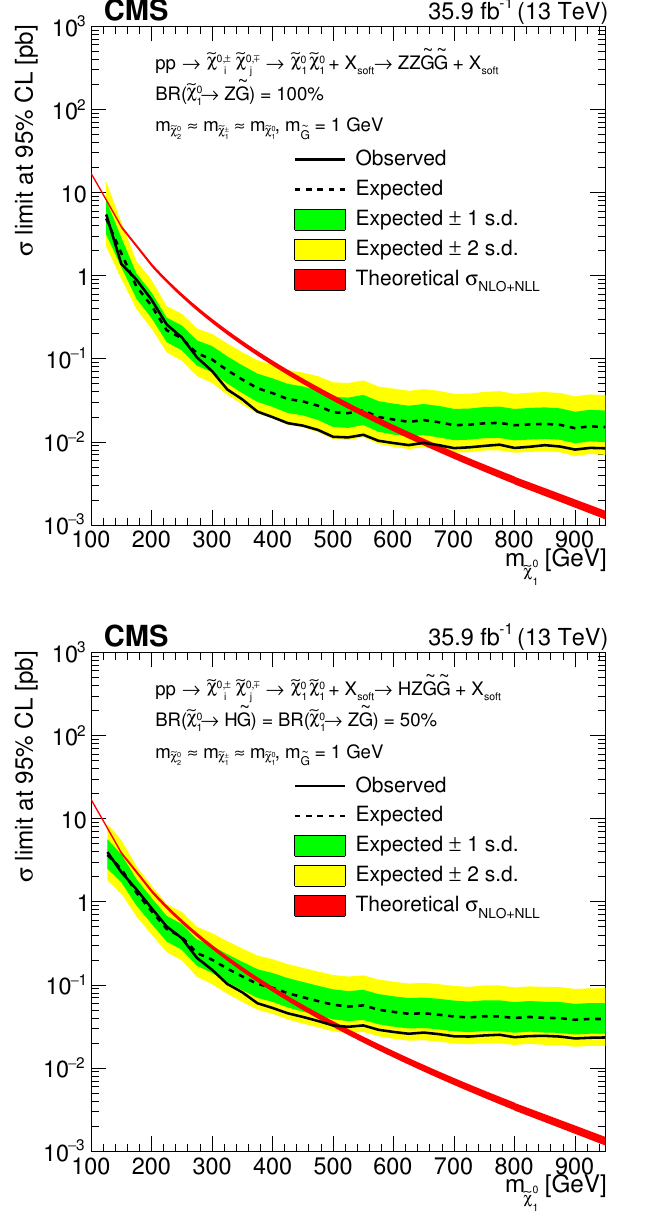
Figure 9 . Cross section upper limit and exclusion lines at 95% CL, as a function of the for the search for EW production in the ZZ topology (upper) and with a 50% branching fraction to each of the Z and Higgs bosons (lower). The red band shows the theoretical cross section, with the thickness of band representing the theoretical uncertainty in the signal cross section. Regions where the black dotted line reaches below the theoretical cross section are expected to be excluded. The green (yellow) band indicates the region containing 68 (95)% of the distribution of limits expected under the background-only hypothesis. The observed upper limit on the cross section is shown with a solid black line.